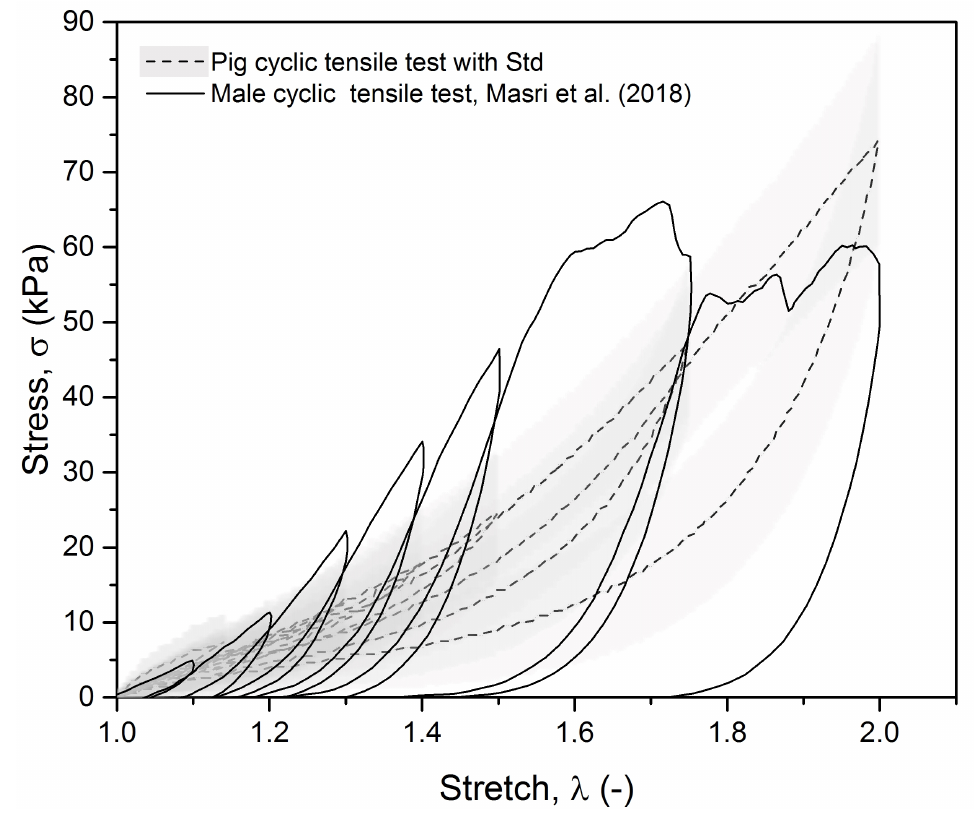
Figure 9. Comparison of the experimental results of circumferential samples of the urethra from male pig and male human subjects (grey ribbon—STD of the results of the current